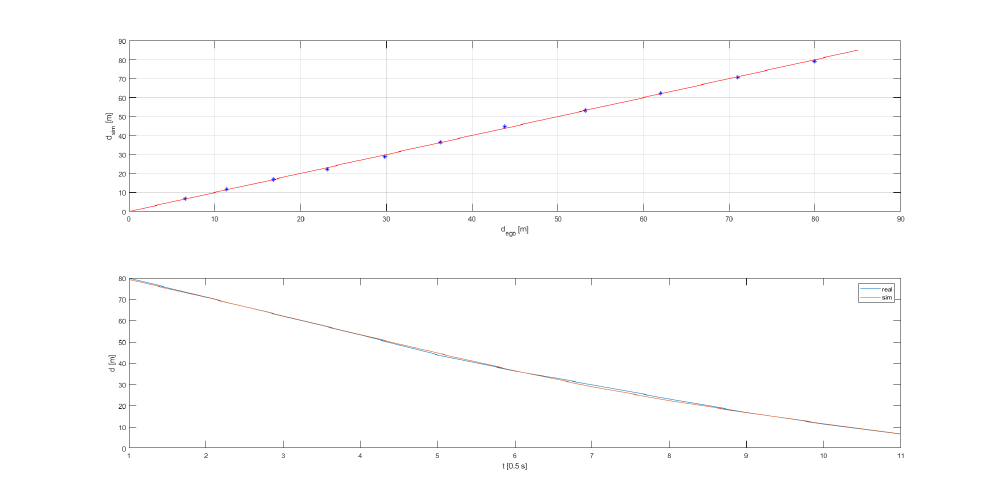
Figure A10. Validation of the real and estimated distance between ego target vehicle in scenario